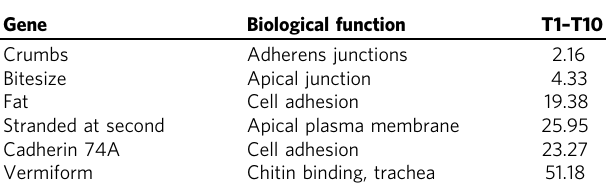
Table 1 Epithelial genes become highly expressed after several rounds of